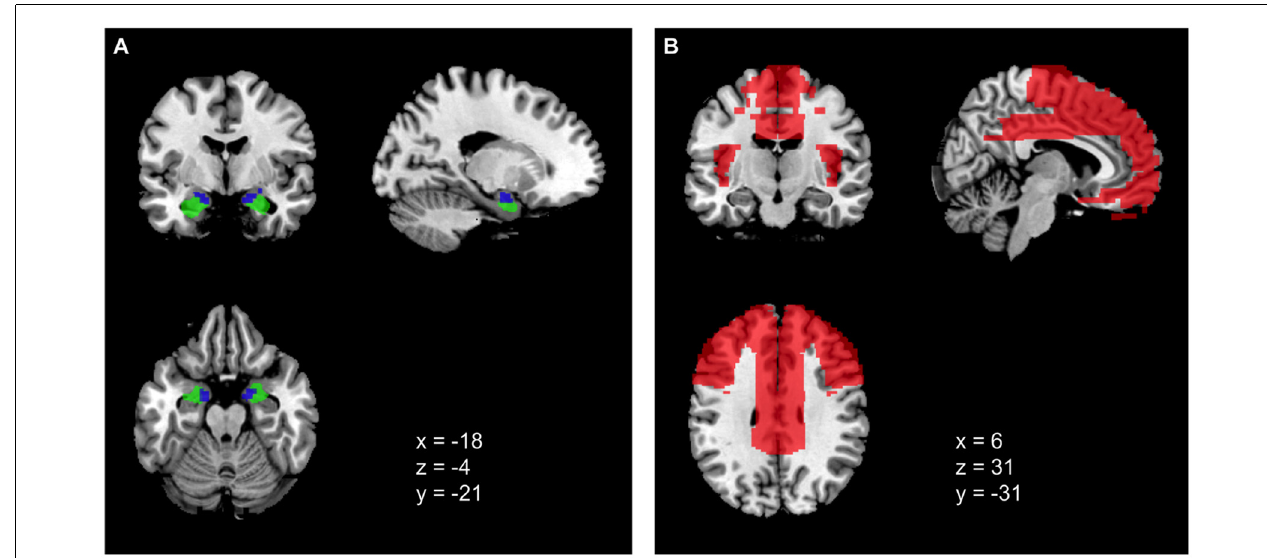
FIGURE 1 | (A) Amygdala seed regions, blue = CMA, green = BLA. (B) Prefrontal cortex (PFC) ROI mask encompassing different regions of the frontal lobe, cingulate gyri, and insula (see Picó-Pérez et al.,